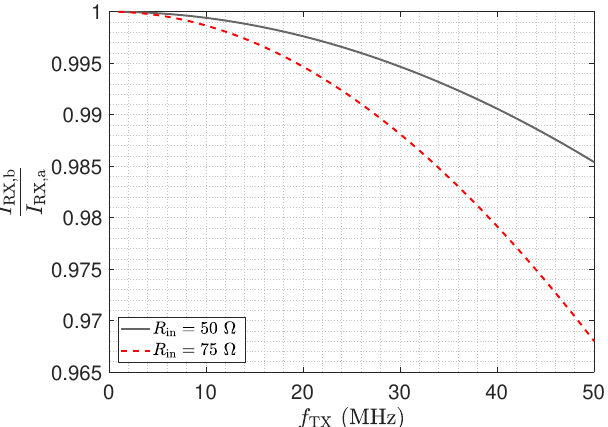
Figure 6. Current ratio I RX,b / I RX,a of the received currents determined with the circuit topologies shown in Figure